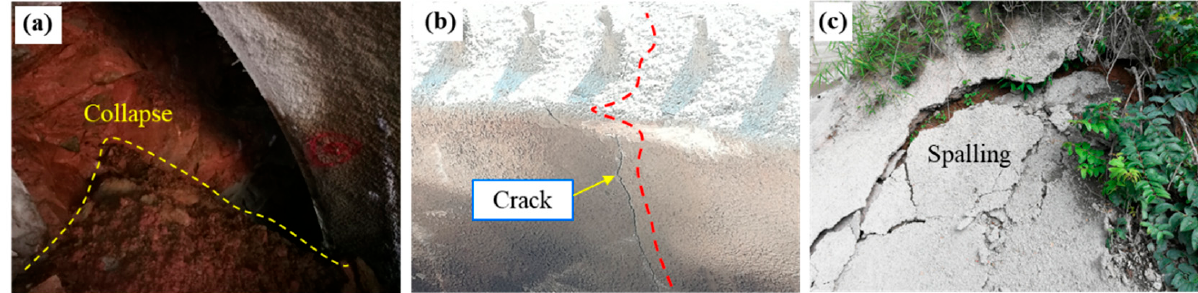
Figure 5. Phenomena before collapse: ( a ) local collapse of tunnel face; ( b ) lining cracking; ( c ) shotcrete spalling.